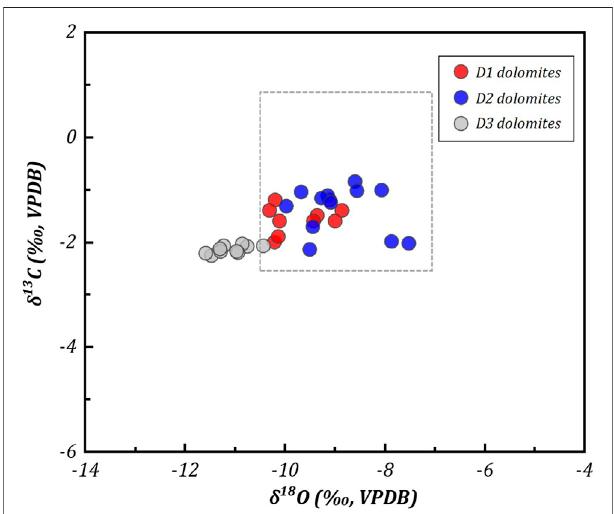
FIGURE 4 | Scatter diagrams of δ 18 O vs. δ 13 C of the investigated Middle – Upper Cambrian Xixiangchi dolomites. The dotted square shows the isotopic composition of the well-preserved Middle – Upper Cambrian carbonates (Veizer et al., 1999).